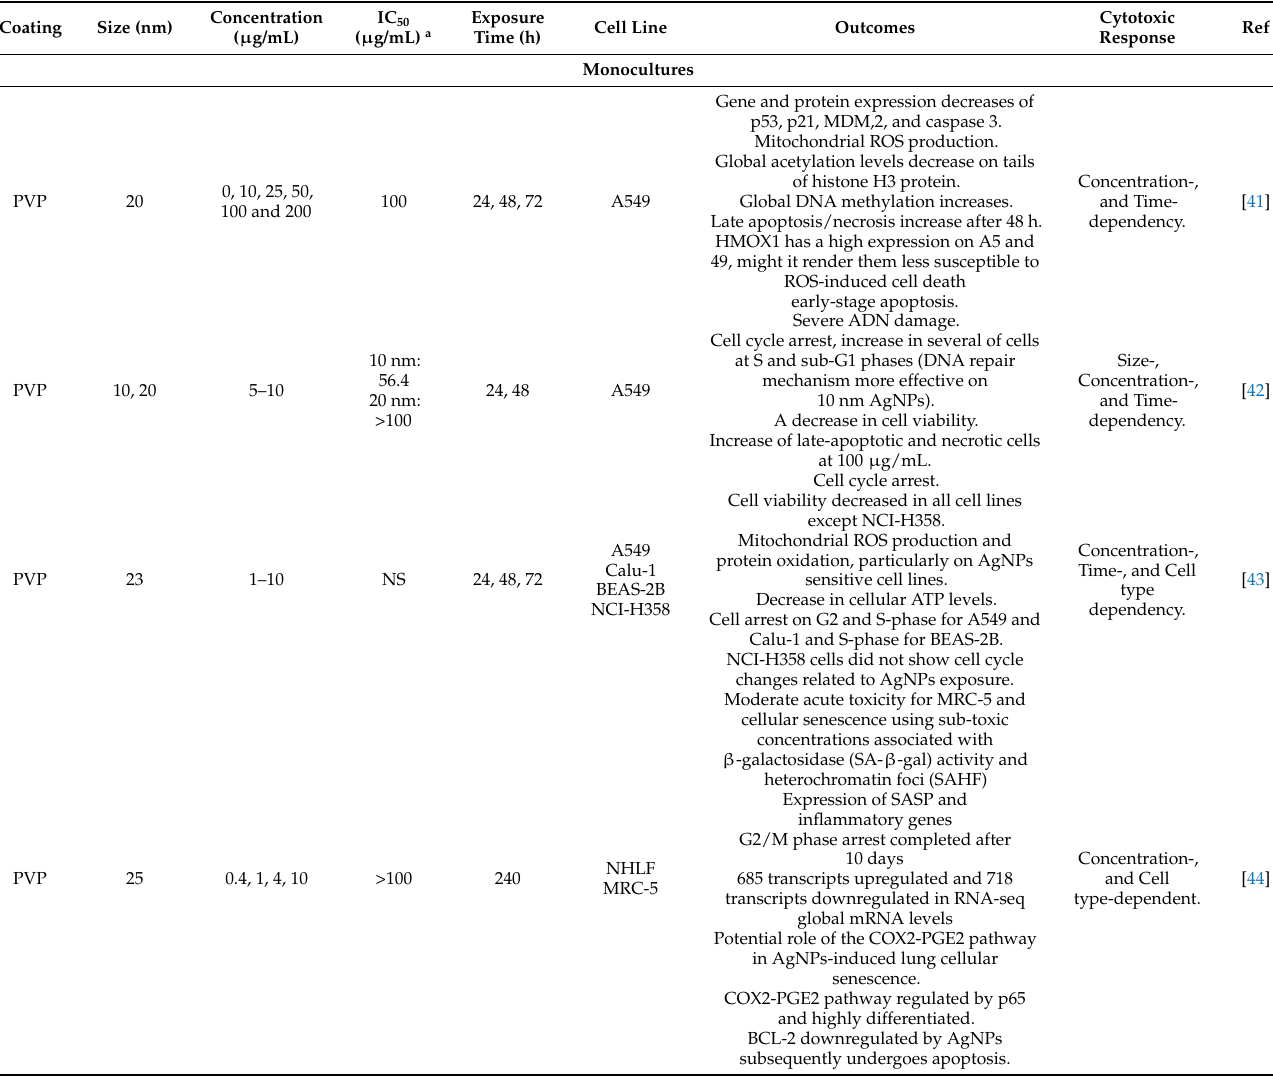
Figure 1. Schematic representation of AgNP formulations: uncoated ( A ) and with different coating agents; phytogenic ( B ), citrate ( C ), and PVP ( D ). Table 1. Cytotoxic effect of AgNPs in different lung cell